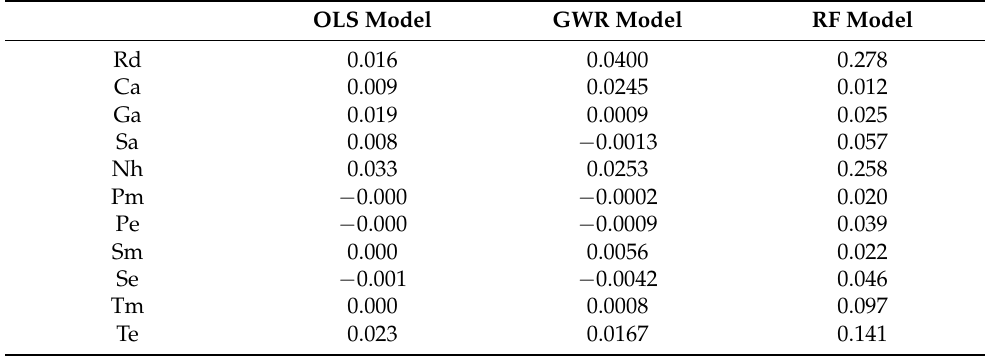
Table 8. The influence of each variable on forest loss in the statistical (OLS and GWR) and machine- learning (RF) models. See Table 3 for variable